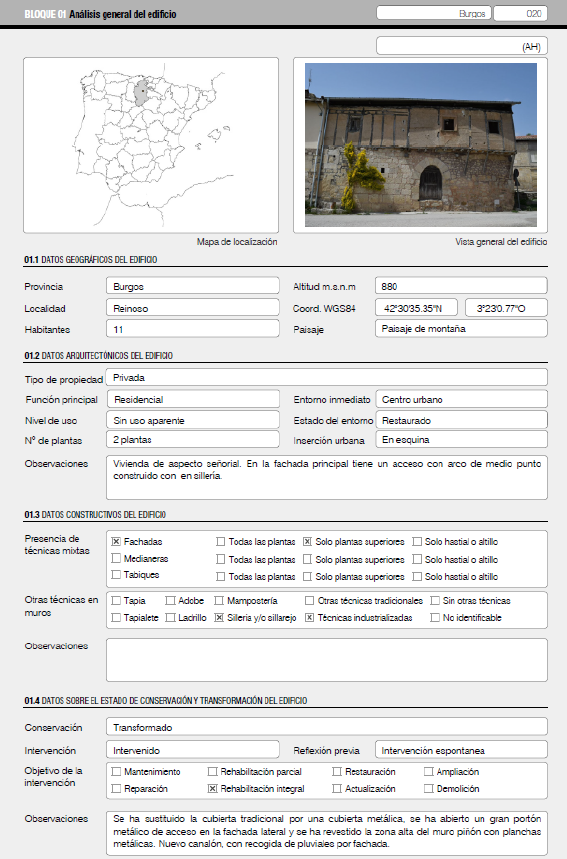
Figure 3. First part of the proposed study sheet, with general data about the building. Example located in Reinoso